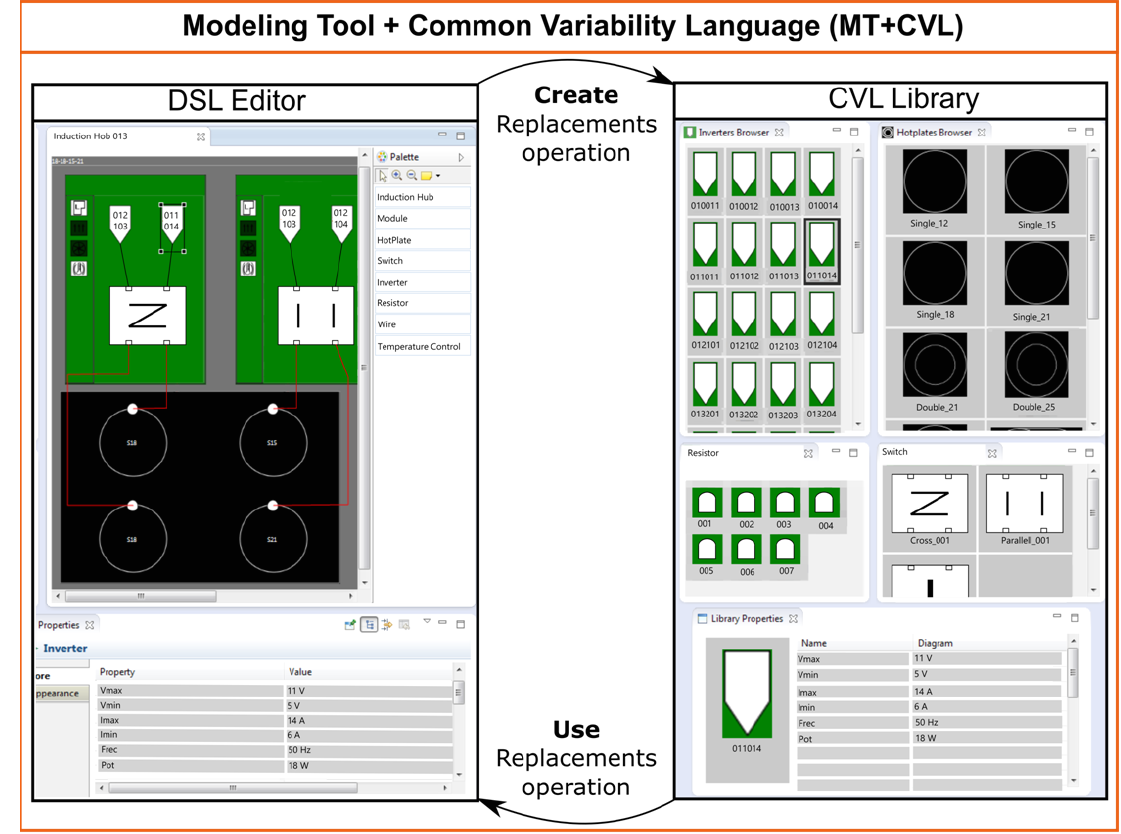
Figure 7. Induction Hob